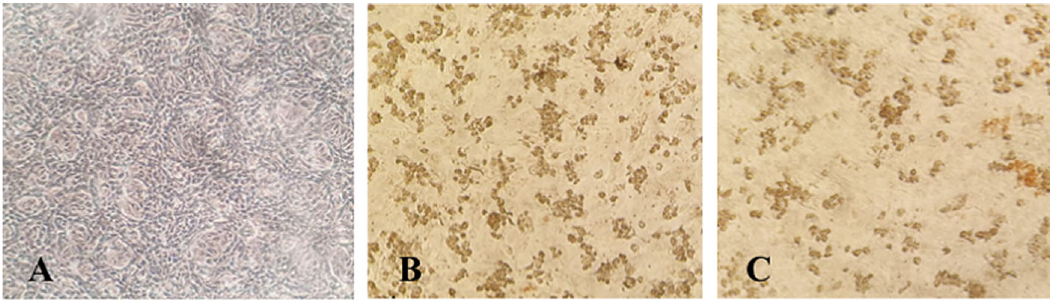
Figure 4. Severe acute respiratory syndrome coronavirus 2 (SARS-CoV-2) Vero E6 infected cells, immunocyto- chemistry using (A) uninfected Vero E6 cells as control; (B) rabbit antibody serum, (C) human antibody serum (100 (cid:1) magnification).